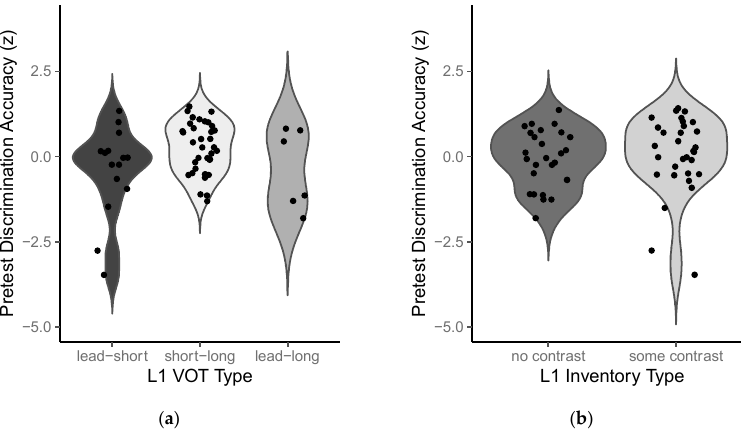
Figure 2. Violin plots showing the probability density of pretest discrimination accuracies (standardized) in each L1 group in ( a ) the stop study and ( b ) the vowel study. Superimposed points (jittered along the x ‐ axis) represent individual participants.